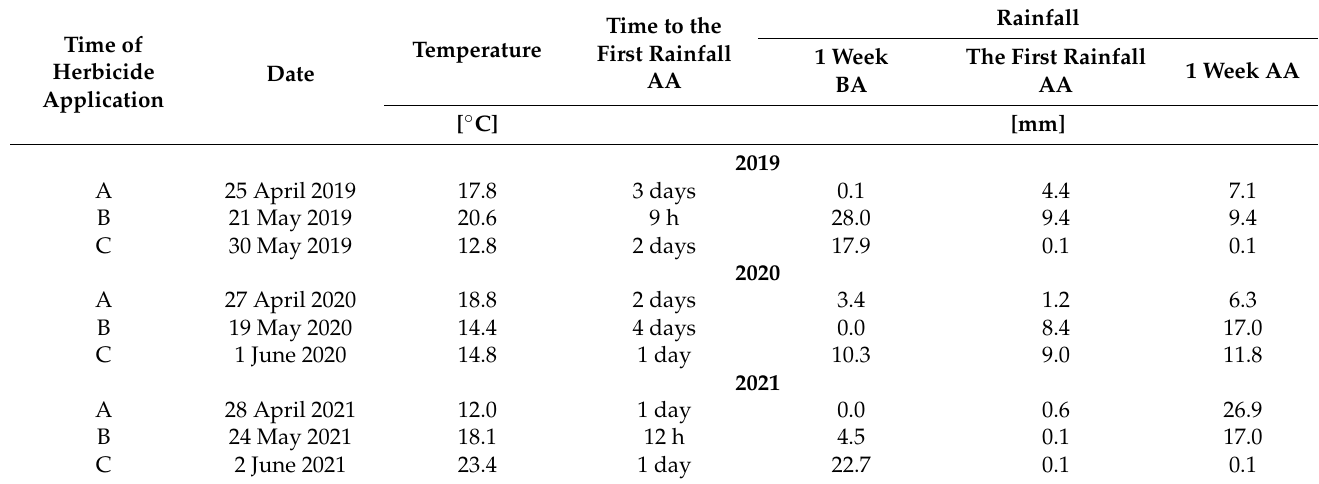
Table 2. Meteorological conditions for individual